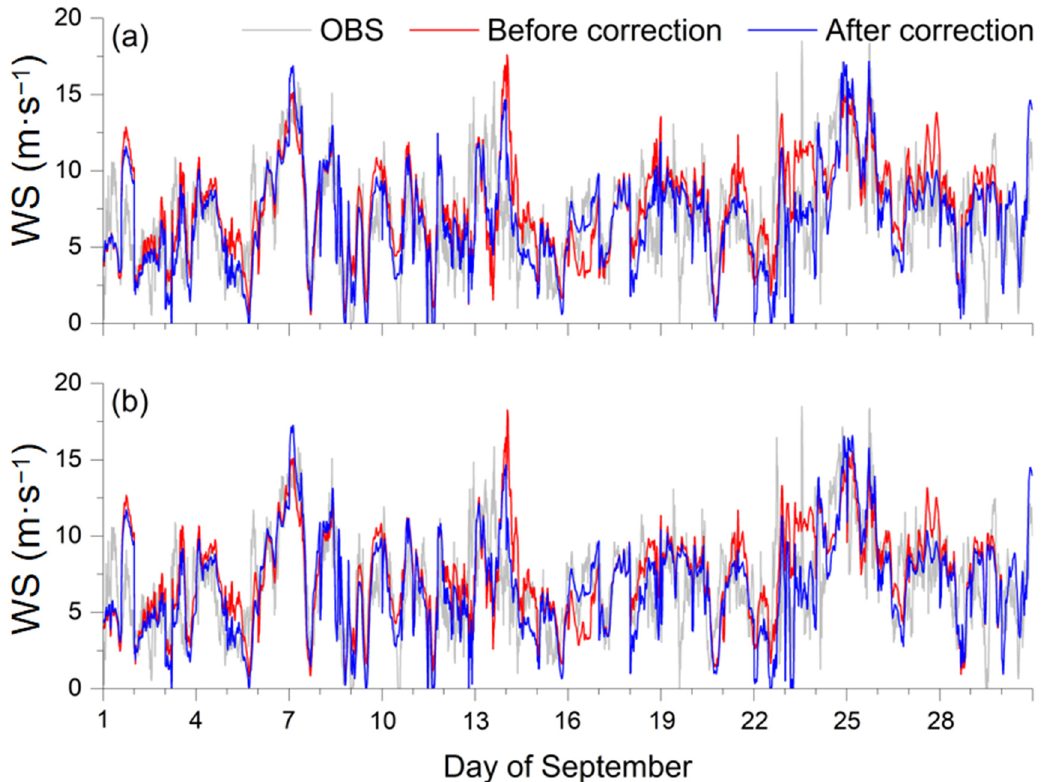
Figure 5. Comparison between observational hourly wind speed (OBS, gray lines), WRF output (before the correction, red lines), and interpolation or replacement corrections (after correction, blue lines) of ( a ) bilinear interpolation and ( b ) nearest replacement.